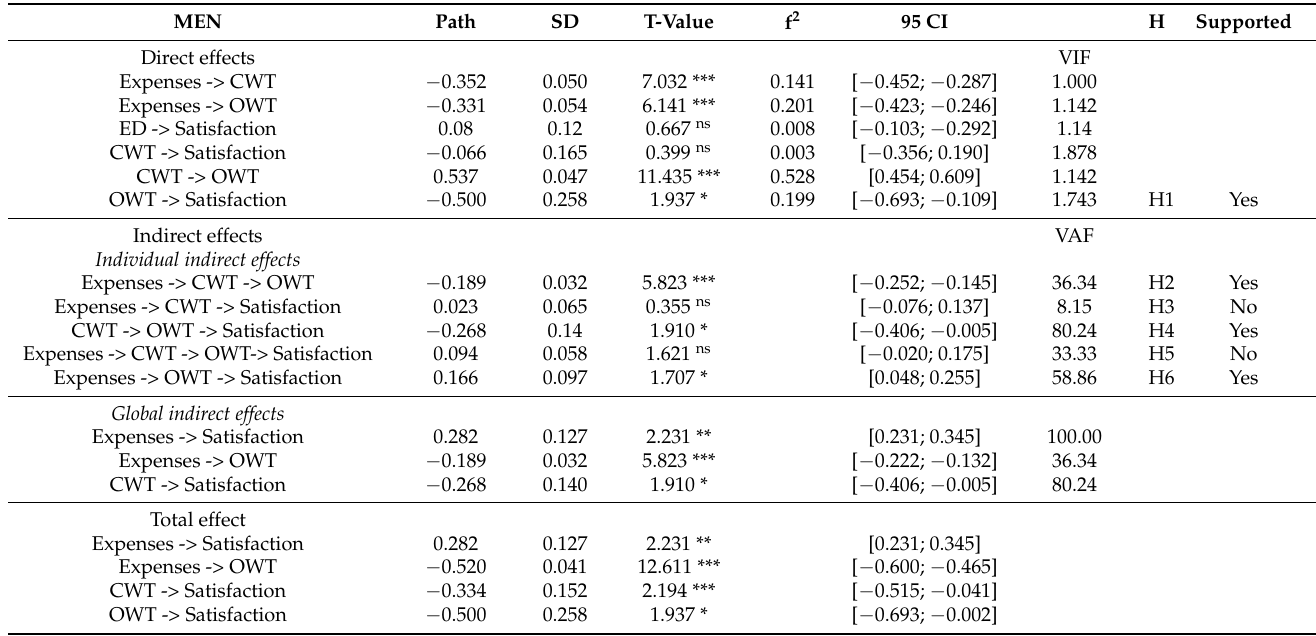
Table A1. Assessment of the structural model for men.